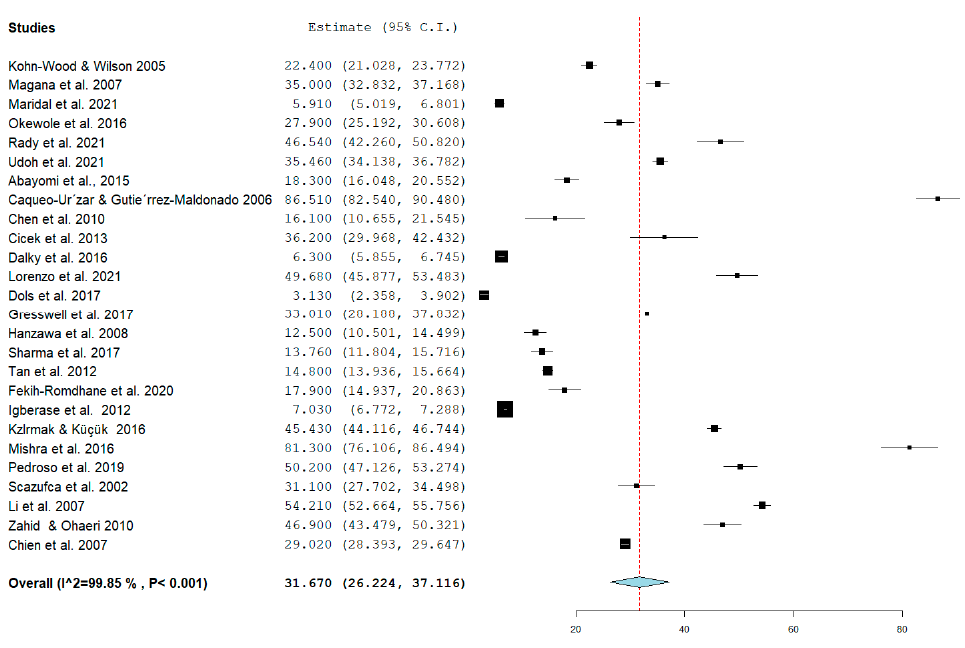
Figure 2. Pooled prevalence of caregiver burden among caregivers of patients with mental